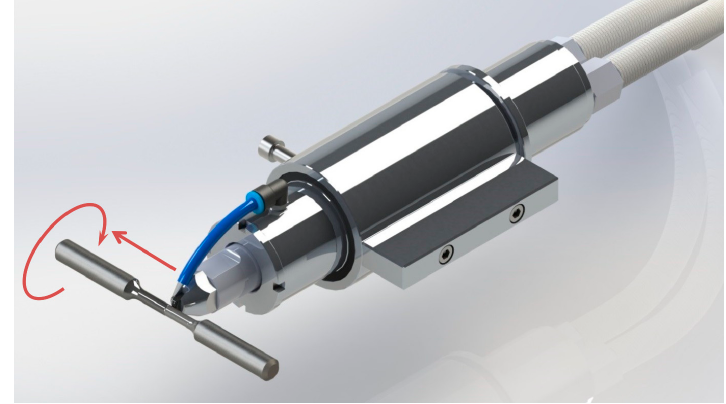
Figure 4. Model of the ultrasonic impact peening process.